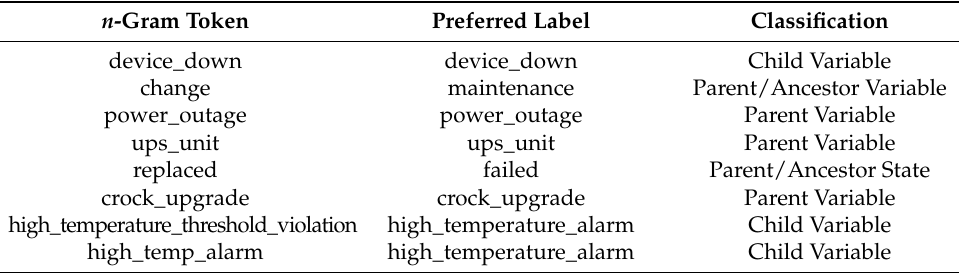
Table 7. List of highest occurring tags in decreasing order and their